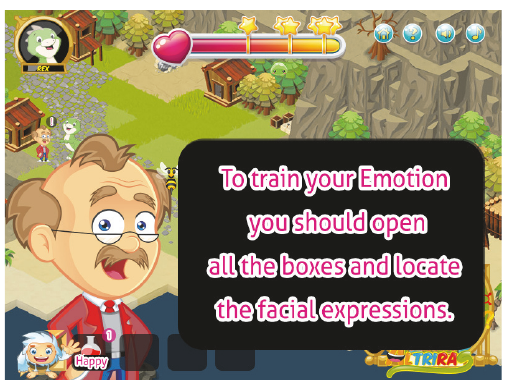
Figure 12: Rex interacting with characters of the environment.